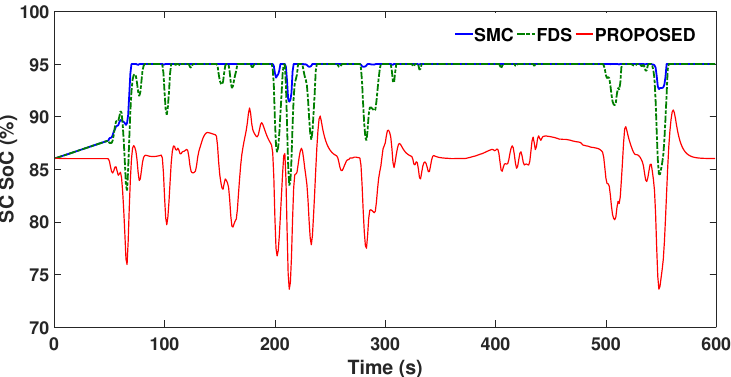
Figure 17. Comparison of SC SOC with SMC, FDS, and IHSEMS under NYCC driving cycle.